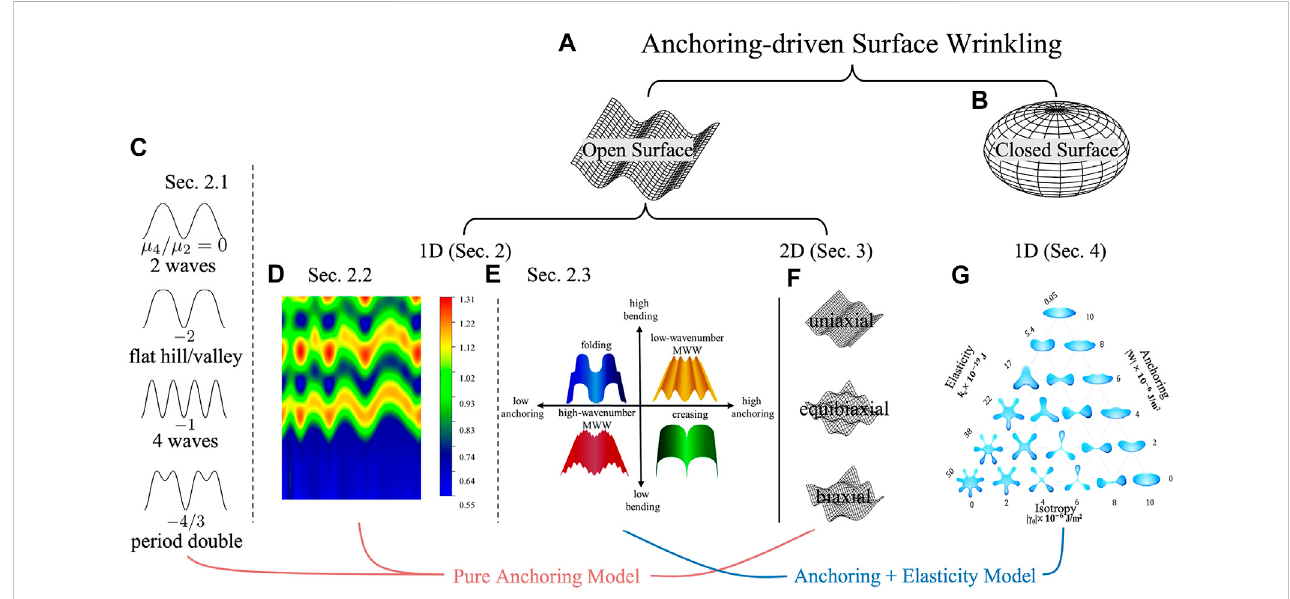
FIGURE 1 Structure, organization, and contents of this review on liquid crystal biomimetics of functional surfaces via surface pattern formation (wrinkling, folding, and creasing). The generic anchoring-driven surface wrinkling phenomenon is observed in both open surfaces (A) and closed surfaces (B) . (C) 1D surface studiedwith ahigherorderquartic anchoring model. (D) 1D surfacewithspatiallyvarying helixpitch. (E) 1Dsurfaceevaluatedbyaquadratic anchoring model, with consideration of membrane bending elasticity. (F) 2D surface studied with a quadratic anchoring model. (G) The morphology of 1D droplet is evaluated by an anchoring model modi fi ed with membrane bending elasticity. (D) Is reprinted from (Rofouie et al., 2015a), with the permission of AIP Publishing. (E) Is reproduced from (Rofouie et al., 2017a) with permission from the Royal Society of Chemistry. (G) Is reproduced from (Rofouie et al., 2017b) with permission from the Royal Society of